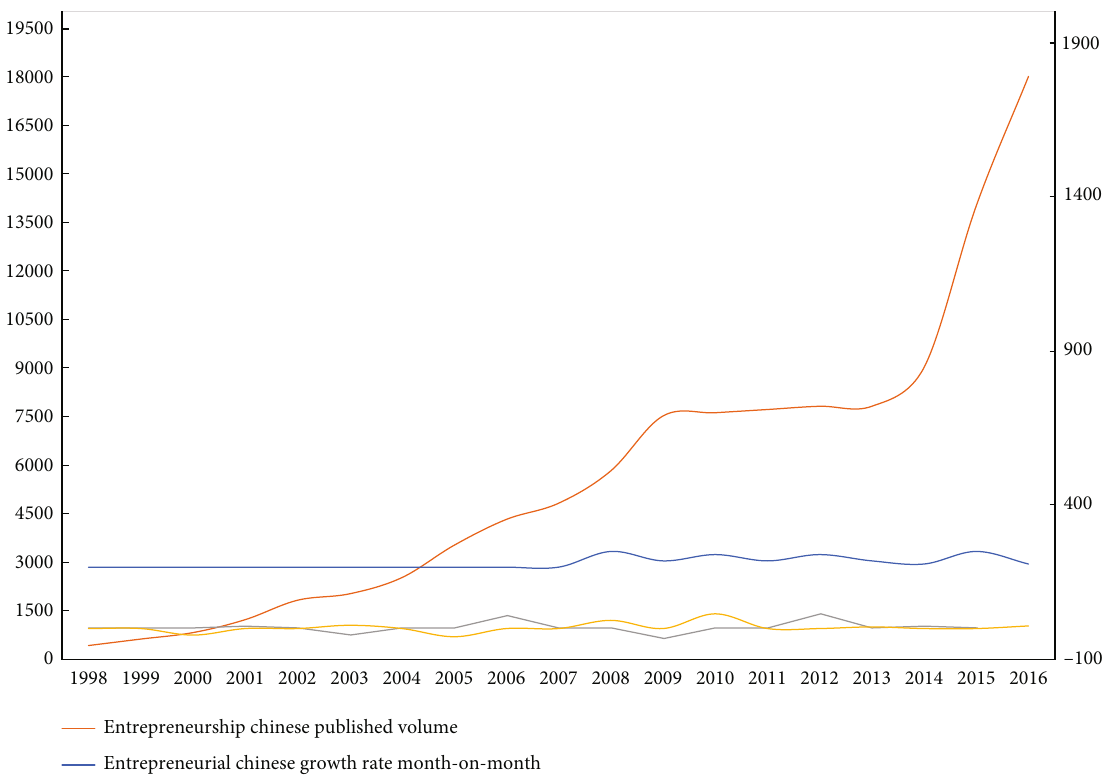
Figure 1: Academic attention to entrepreneurship policy